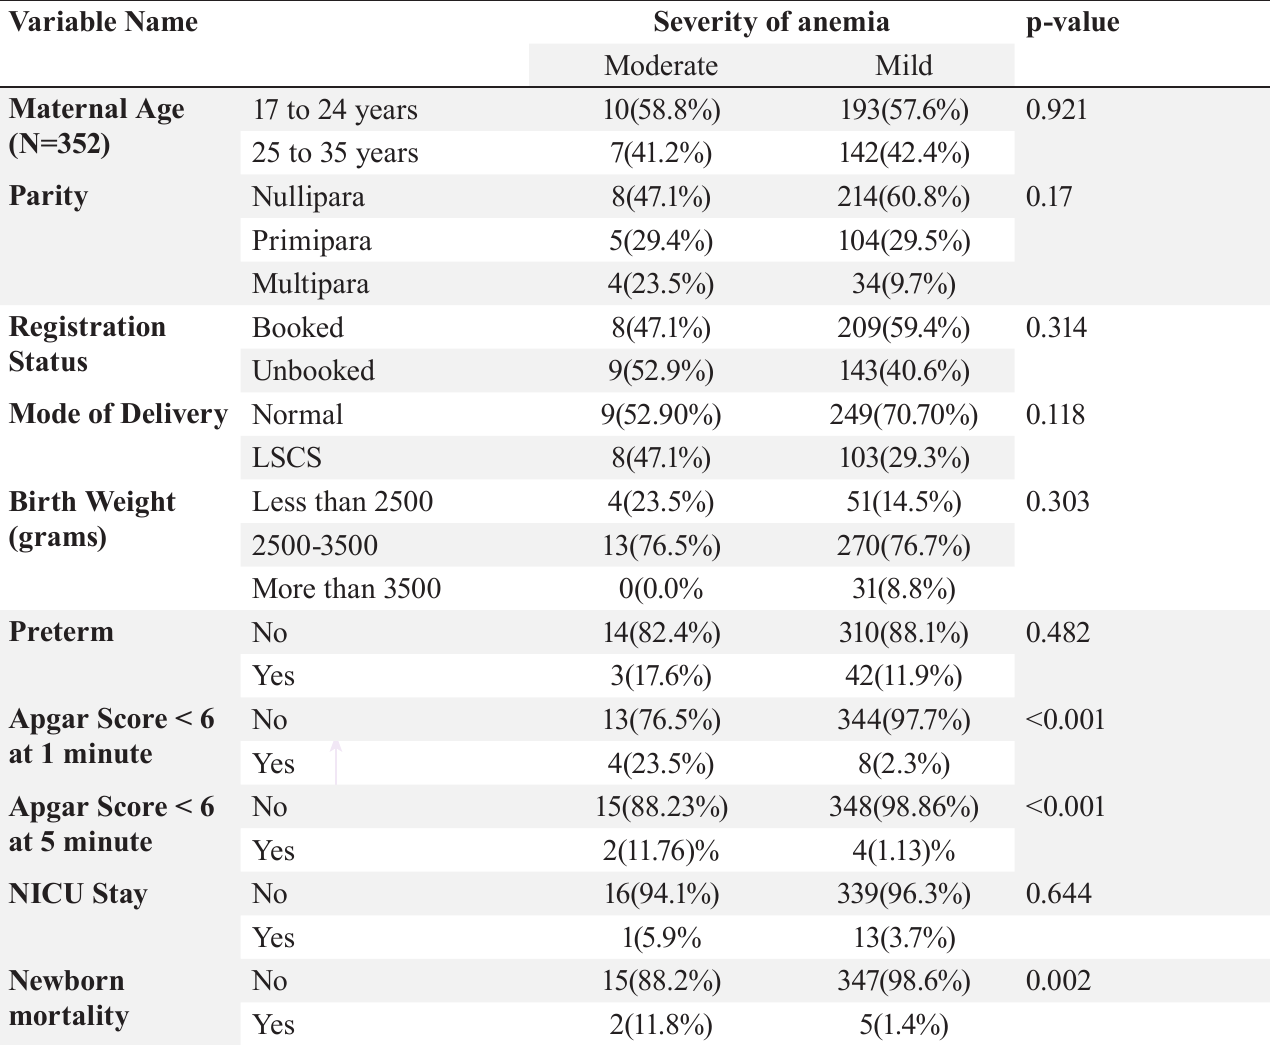
Table 2 Association between socio-clinical characteristics with the severity of anemia.